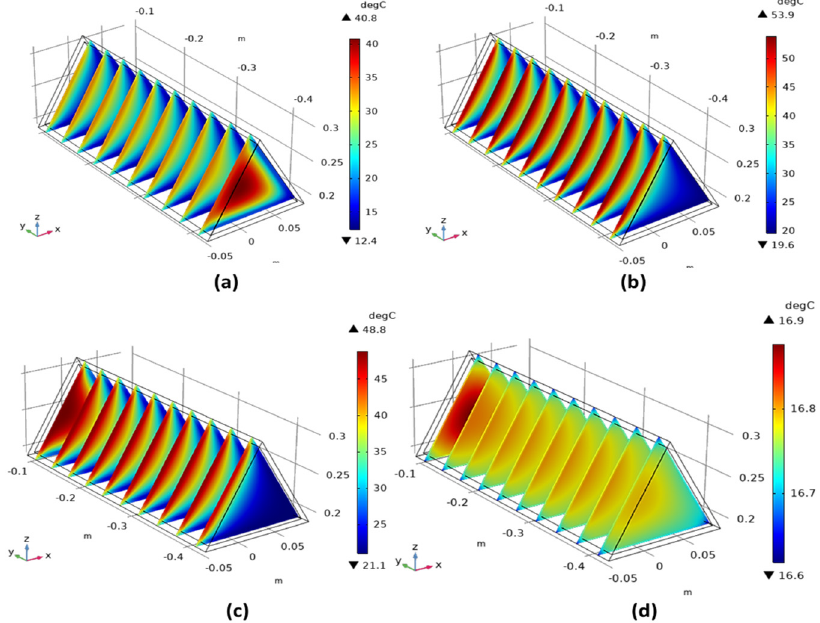
Figure 18. The temperature distribution of the SHC through ( a ) morning, ( b ) zenith, ( c ) afternoon, and ( d ) night.